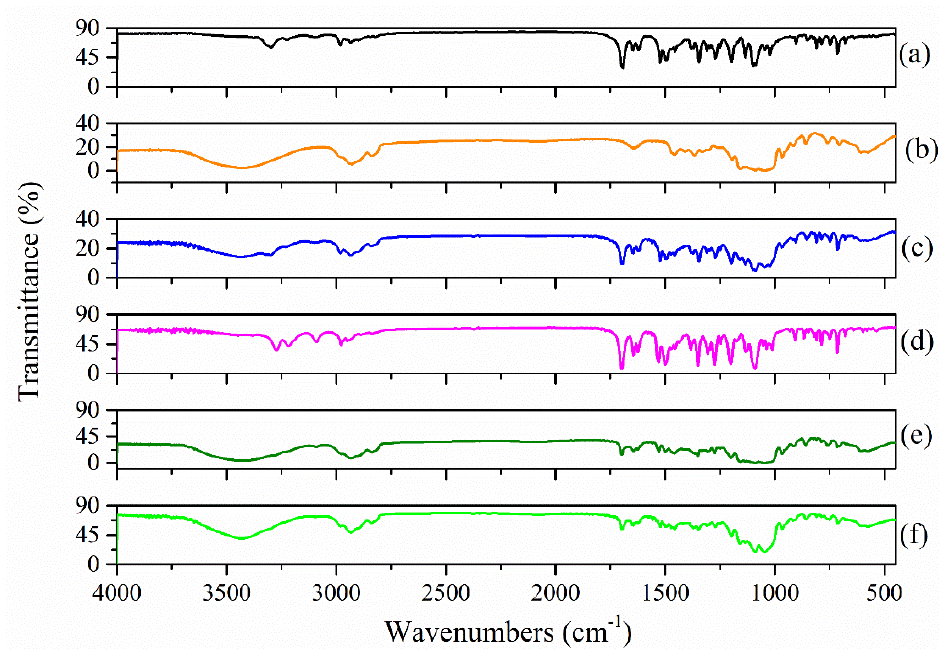
Figure 4. FTIR spectra of ( a ) Nim; ( b ) Me- β -CD; ( c ) Nim – Me- β -CD physical mixture; ( d ) Nim – Me- β -CD coprecipitation method; ( e ) Nim – Me- β -CD lyophilization method; ( f ) Nim – Me- β -CD kneading method.